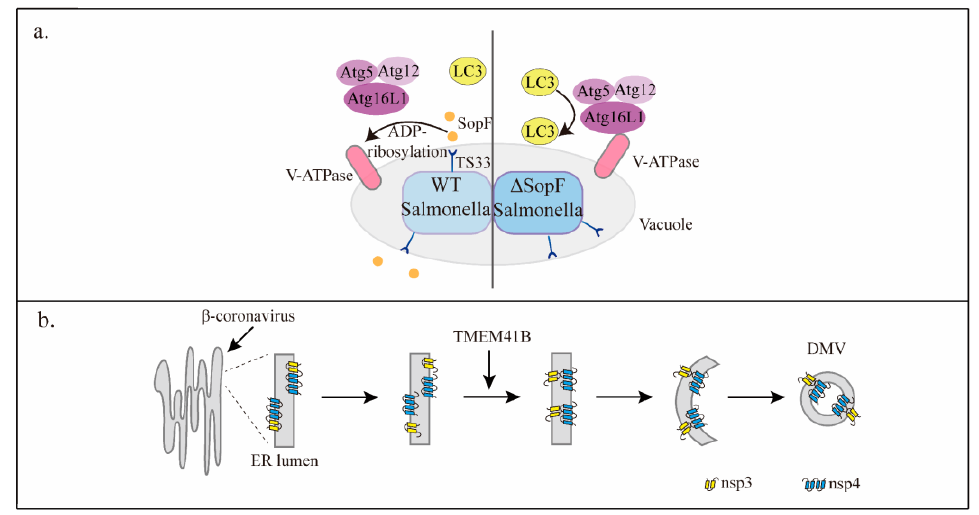
Figure 4. The different mechanisms of escape from xenophagy. ( a ) When cells are infected by Sal- monella , the membrane curvature of the vacuole changes and the vacuolar membrane is damaged. SopF targets V-ATPase for ADP-ribosylation. The V-ATPase cannot recruit ATG16L1 to the vacuole to initiate LC3 lipidation to escape from xenophagy. ( b ) When cells are infected by β-coronavirus, the β-coronavirus is translated into nsp. The rearrangement and binding of nsp3 and nsp4 induce the bending of the ER lumen to form a membrane curvature and further form DMVs to escape xe-